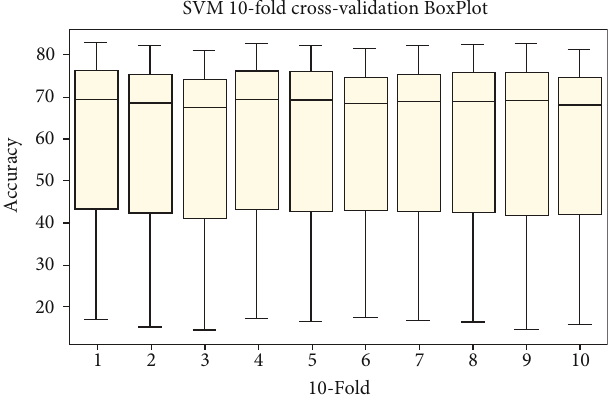
Figure 10: Box plot representation for SVM. Table 5: Accuracy obtained from jackknife testing.